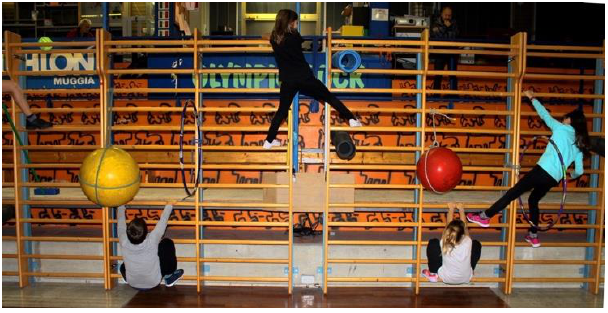
Figure 1. Children performing exercises starting from the left side of the wall bar and moving sideways to pass over.